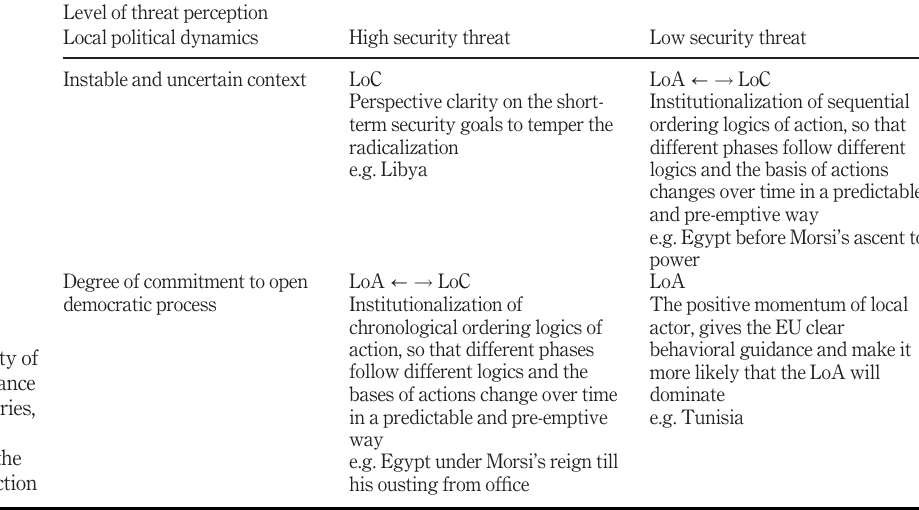
Table I. Variation in the degree of stability of political governance in partner countries, the EU ’ s threat perception and the EU ’ s logics of